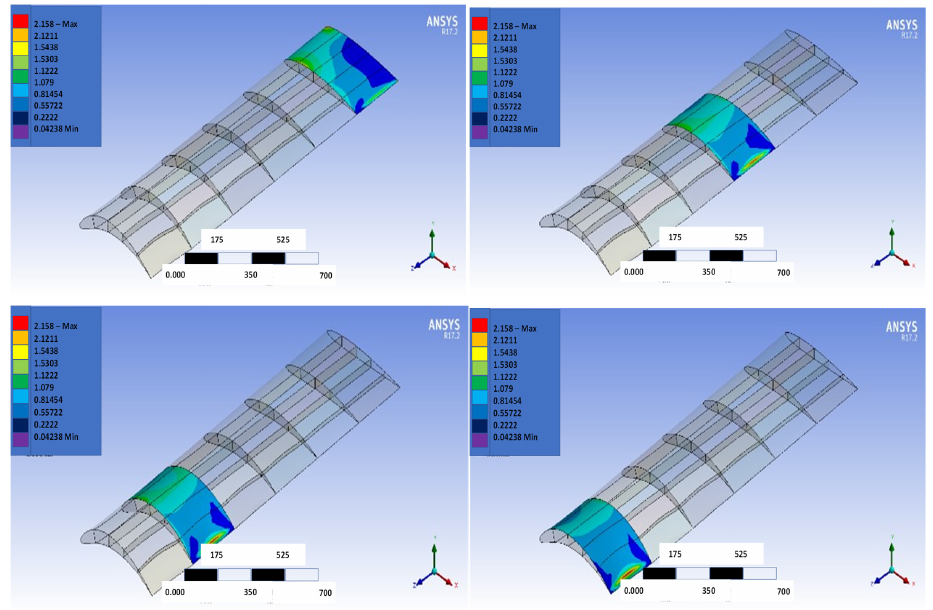
Figure 18. Sectional output (maximum shear stress) distribution to morph NACA2410 to NACA8410 along the wing.